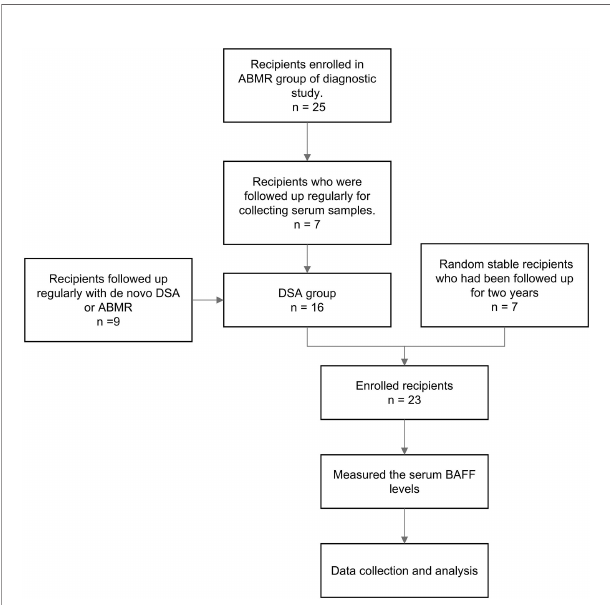
FIGURE 3 | The fl owchart of the nested case-control study. ABMR, antibody-mediated rejection; DSA, donor-speci fi c antibody; BAFF, B cell- activating